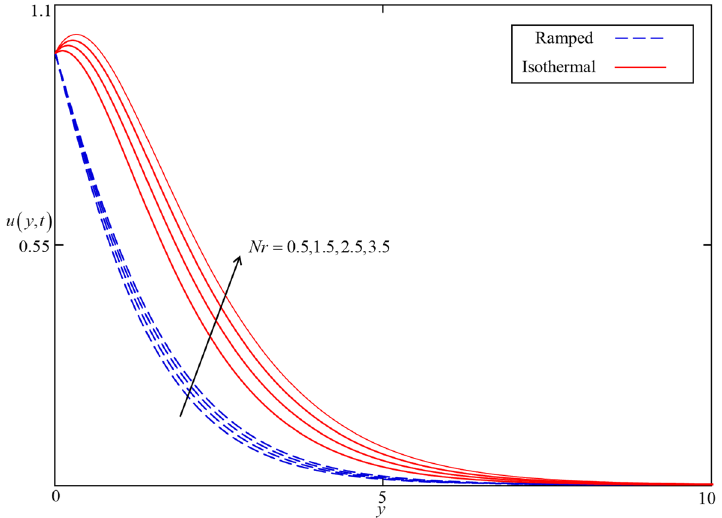
Figure 11. Consequence of Nr on u ω t = 0.15 in case of cylindrical shape nanoparticles.